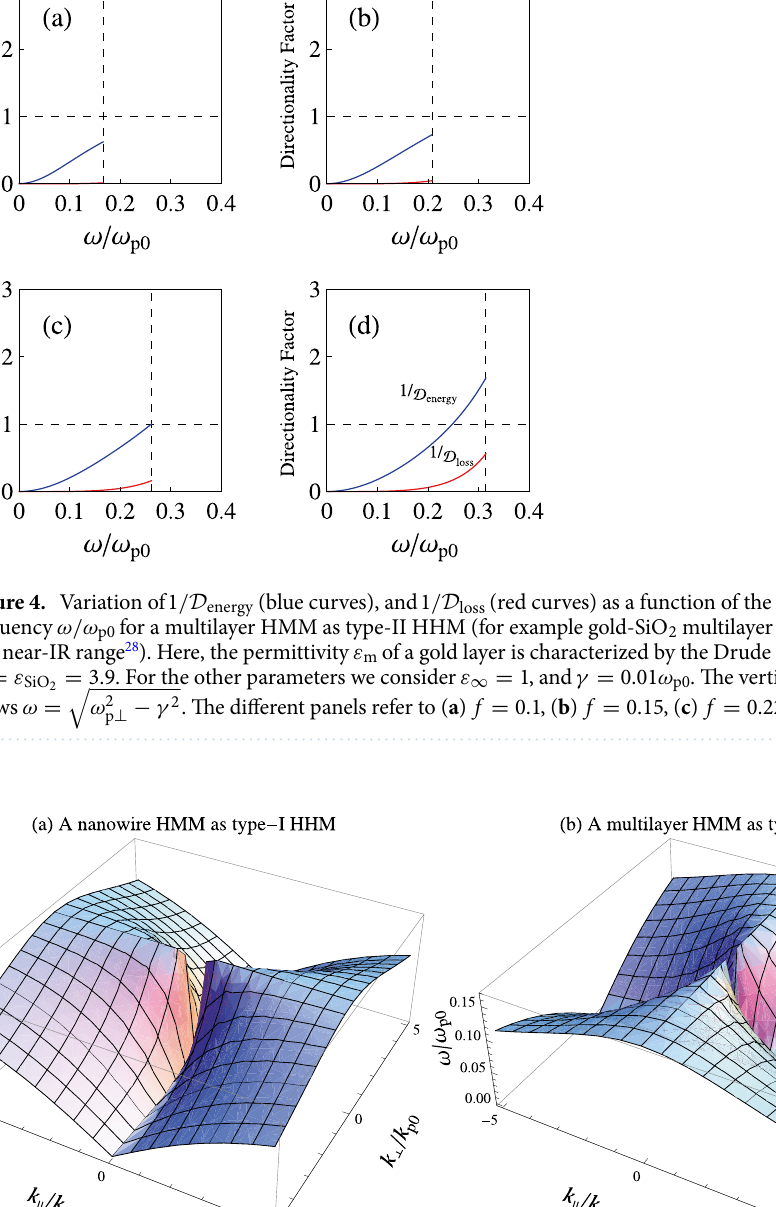
Figure 5. The dispersion relation for ( a ) a nanowire HMM (for example gold nanowire HMM), and ( b ) a multilayer HMM (for example gold-SiO 2 multilayer HMM) in the visible and near-IR range 28 , as type-I and type-II HHMs, respectively. Here, the permittivity of the metal (for example gold) ε m is characterized by the Drude model and for the dielectric we use SiO 2 with ε d ε 1 , f 0.1 , and γ 0 . Also, k p0 is the wavenumber corresponding to the electron plasma frequency = = ∞ = ω p0 / c . The plots are symmetric about the planes k k p0 =